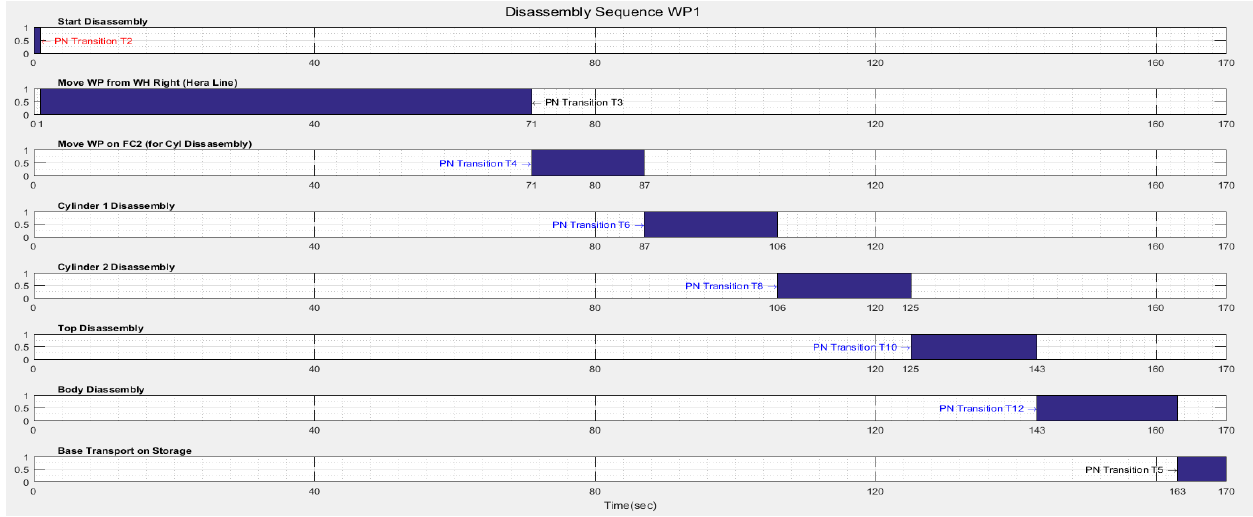
Figure 26. Results for discrete places and transitions on Assembly WP2.